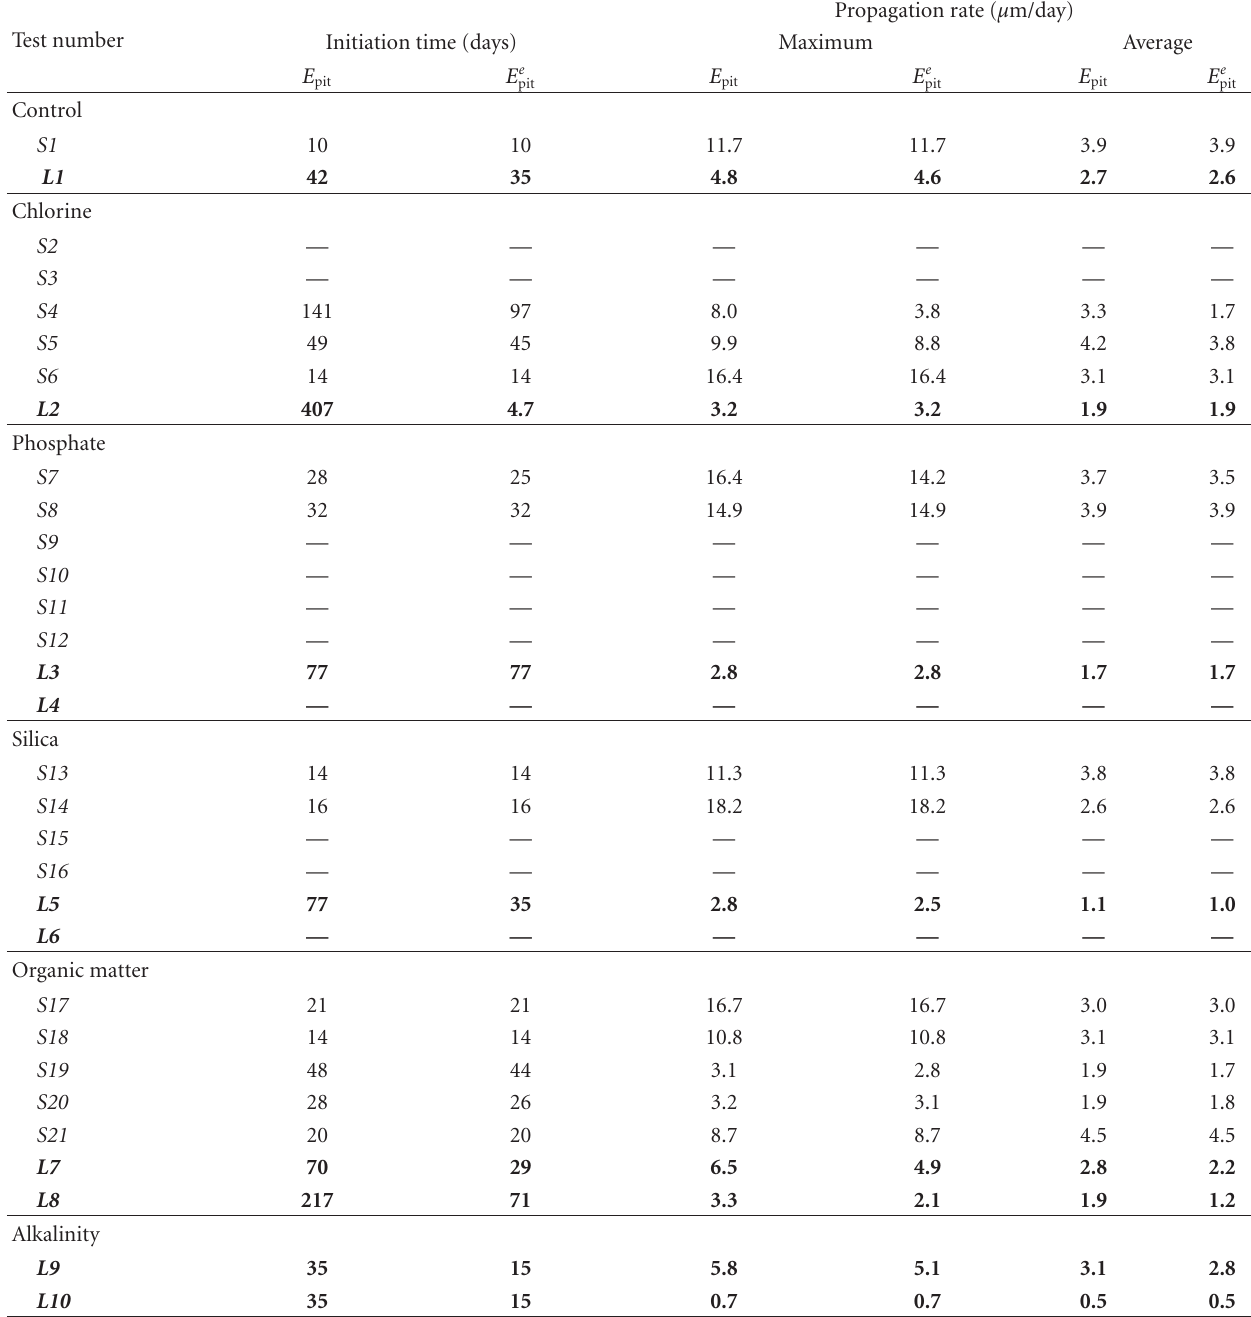
Table 4: Estimated pit initiation times and computed pit propagation rates based on E pit = 325 mV and E e was not observed during test, pit initiation time could not be estimated. Tests are grouped by respective adjustments to control If E pit or E e pit water quality and large-scale results are